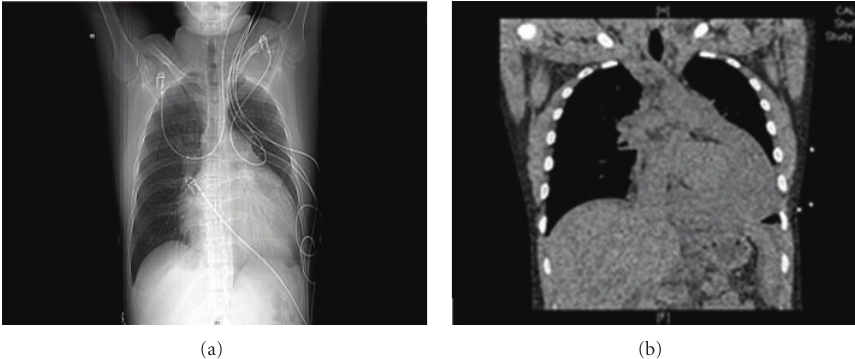
Figure 1: Radiographic imaging; chest X-ray (a) and CT scan (b).